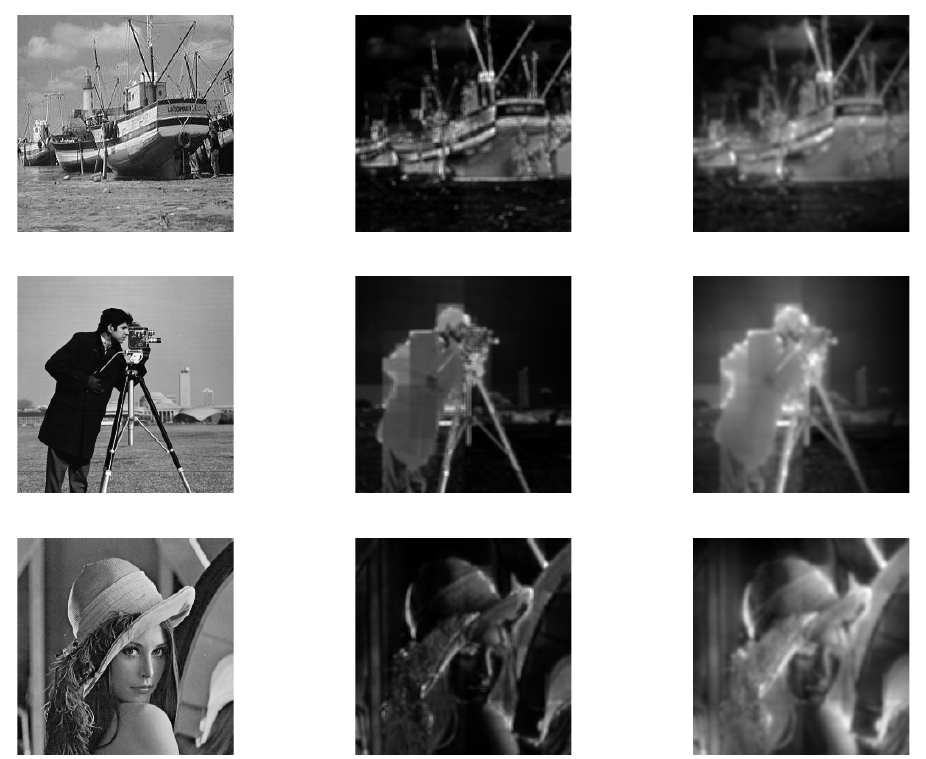
Figure 2. The saliency estimation result of the proposal method in comparison with the MSNR method. From left to right: the original image, the saliency map generated by MSNR method and the saliency map generated by proposal